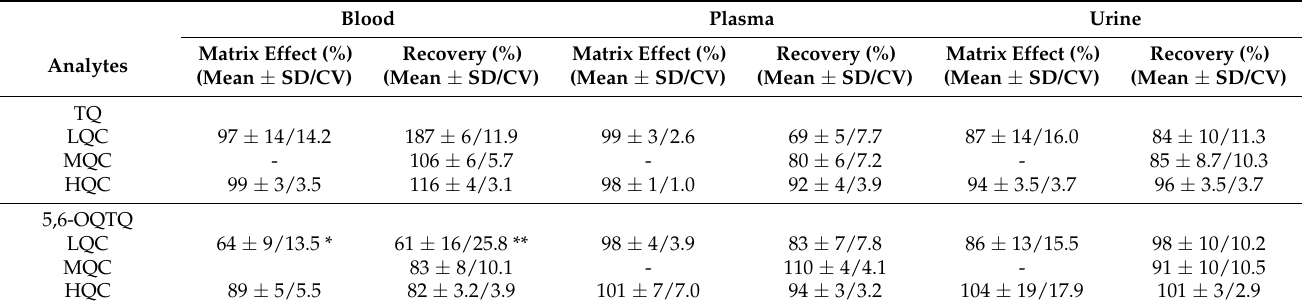
Table 1. Matrix effect and absolute recovery of TQ and 5,6-OQTQ in human blood, plasma and urine. Blood Plasma